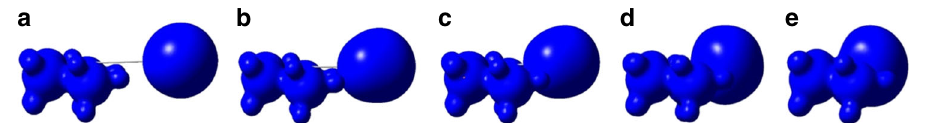
Fig. 5 Electrostatic potential (ESP) surface of the [C] = Th 2 + fragment. As a function of distance this shows the approach of the model BIPM [C] ligand to the Th [ r (Th-C [C] )] at a 6.491 Å, b 5.491 Å, c 4.491 Å, d 3.491 Å, e 2.491 Å, the value in the optimised structure of [C] = Th = NCH 3 . The isovalue is 0.5